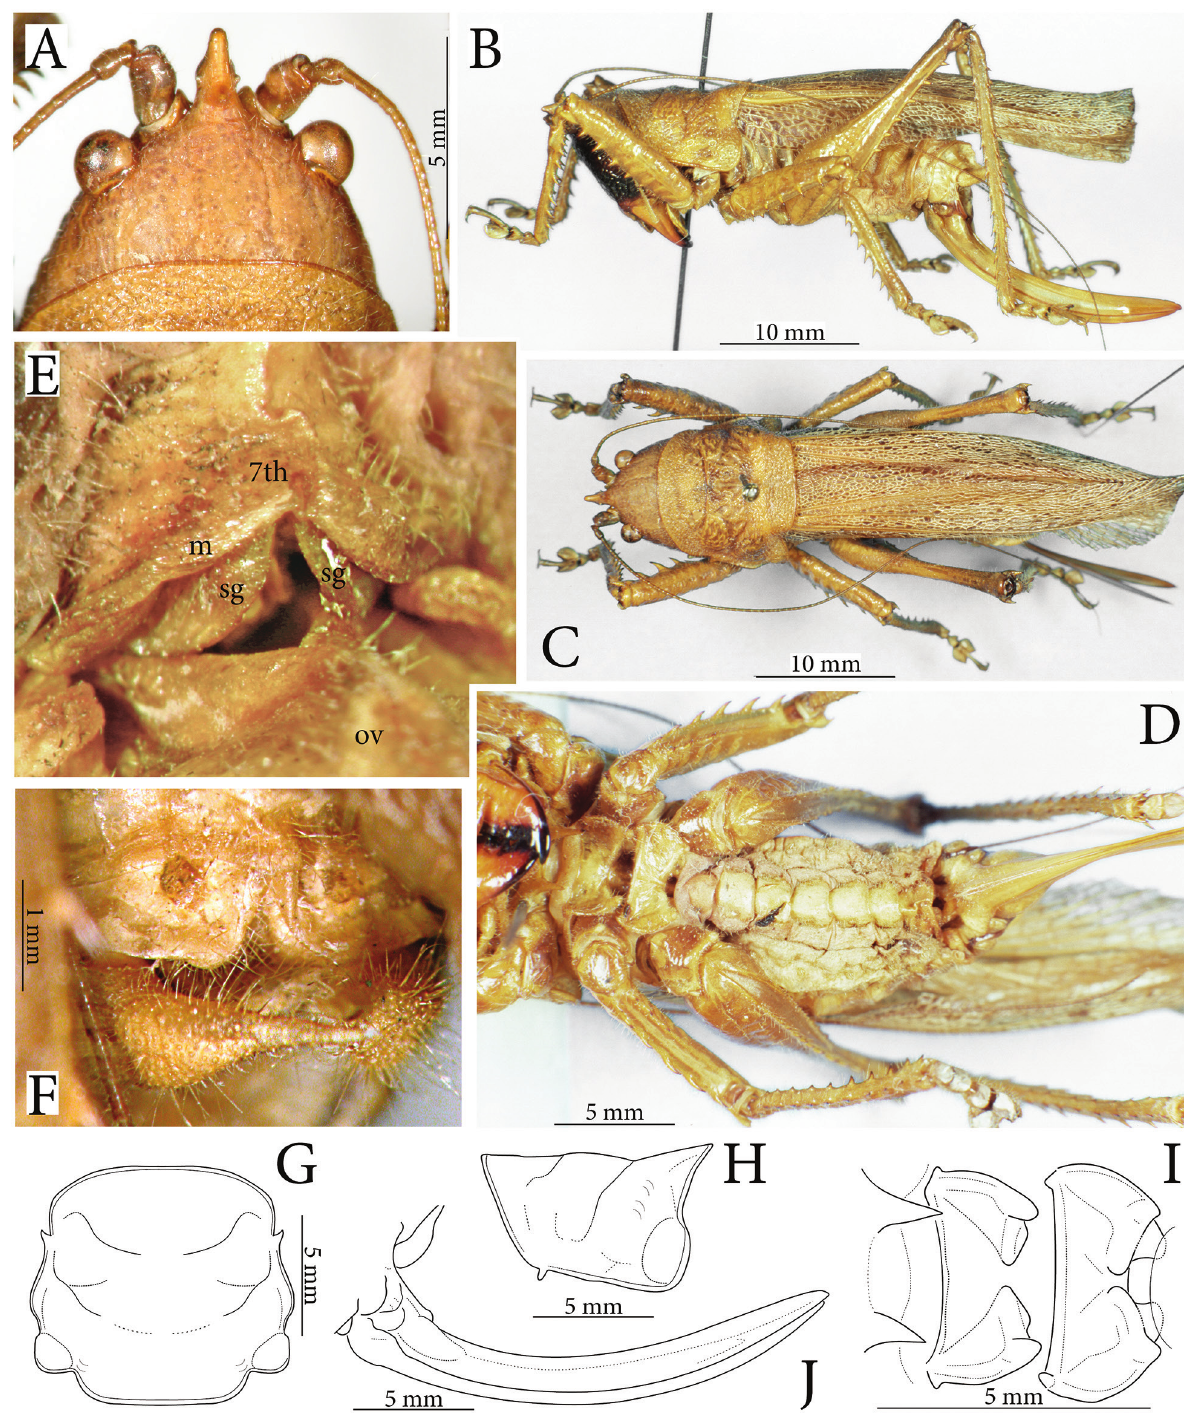
Figure 3. Peracca ( Robustacca ) nigrifrons subgen. & sp. nov. female holotype. A Head in dorsal view; B–D habitus in lateral ( B ), dorsal ( C ) and ventral view ( D ); E female abdominal apex in ventral view, the subgenital plate has the anterior area hidden under the 7 th sternite in the shrunken specimen; F apical tergites and cerci; G, H pronotum in dorsal ( G ) and lateral view ( H ); I thoracic sternites; J ovipositor. Abbreviations: 7 th seventh abdominal sternite, m membranes, ov base of ovipositor, sg apical lobes of subgenital